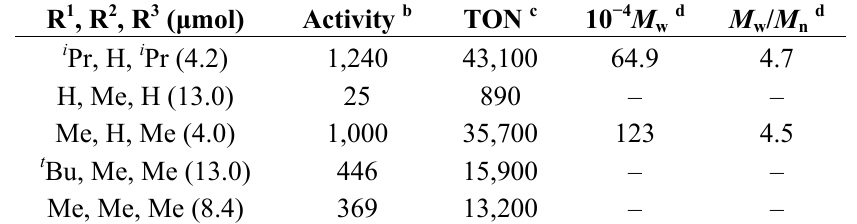
Table 4. Effect of aryloxo substituents toward the activity of ethylene polymerization